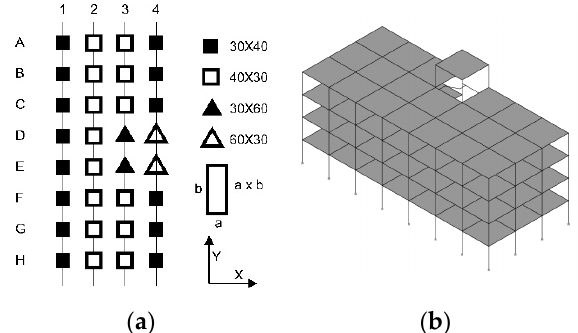
Figure 5. Accelerograms of ( a ) Santa Venerina (2018) and ( b ) L’Aquila (2009).